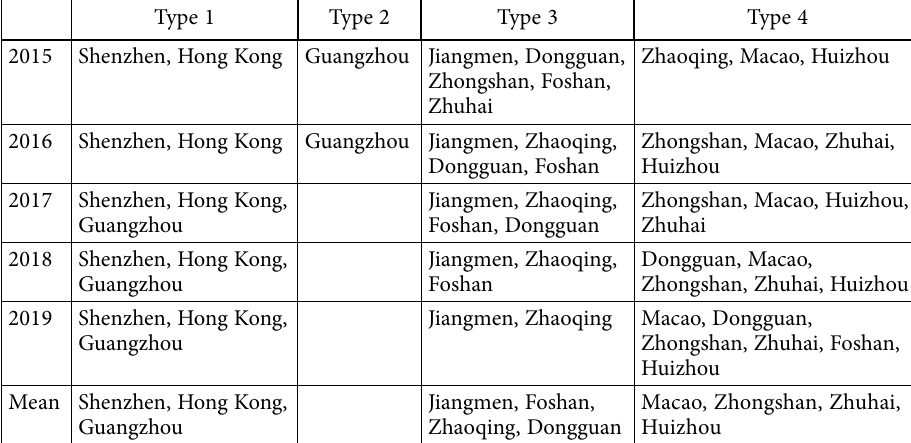
Table 3. Type distribution of green development in the GBA based on duality Type